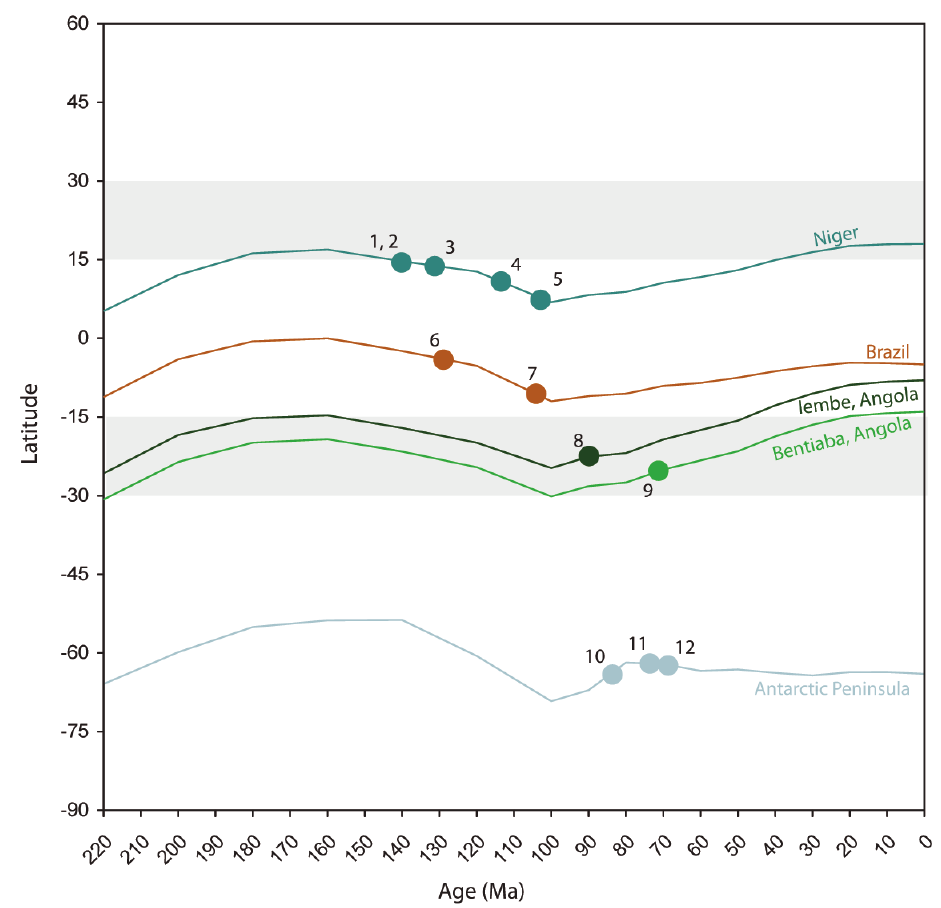
Fig. 3 – Latitudinal trajectories of Gondwana dinosaur localities (listed by number in Table I) in the South Atlantic